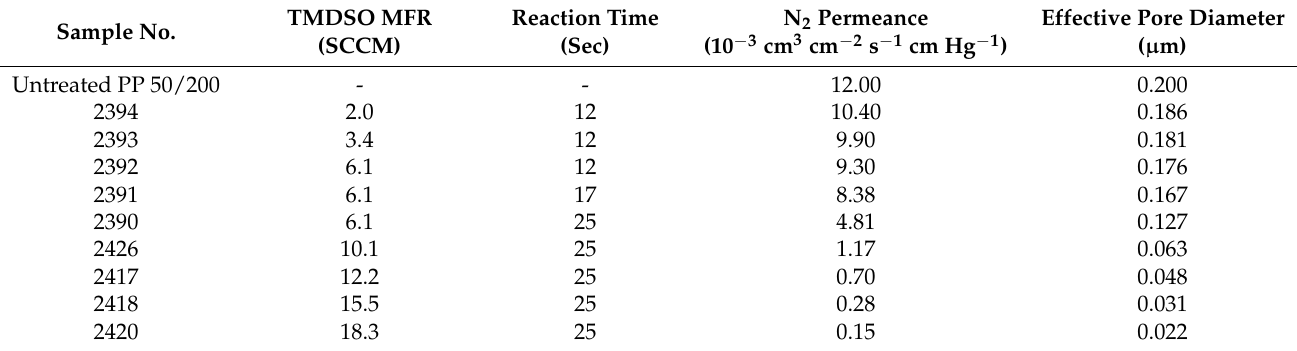
Table 3. Effect of monomer flow rate and reaction time on N 2 permeance (PP50/200). Sample No.